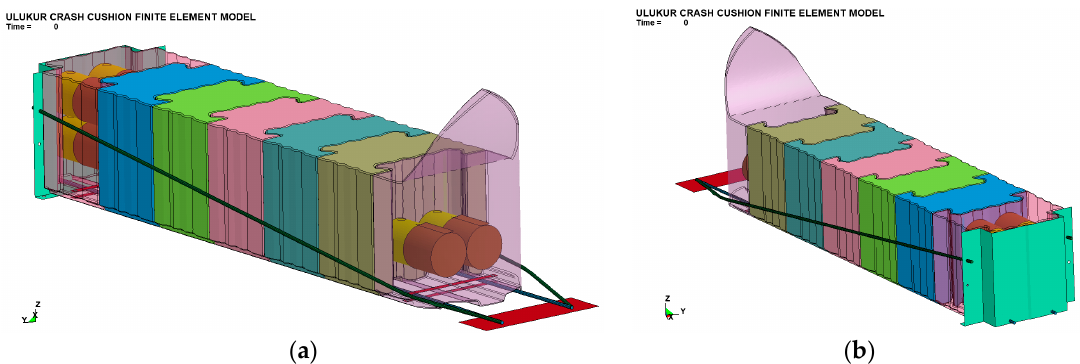
Figure 4. Finite element model of UCC: ( a ) frontal view and ( b ) rear view.